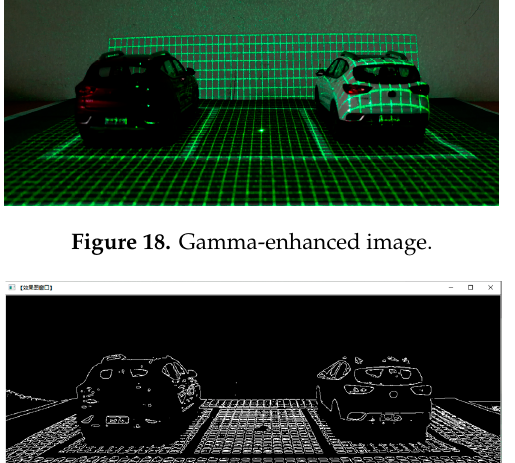
Figure 17. The image of the parking space.